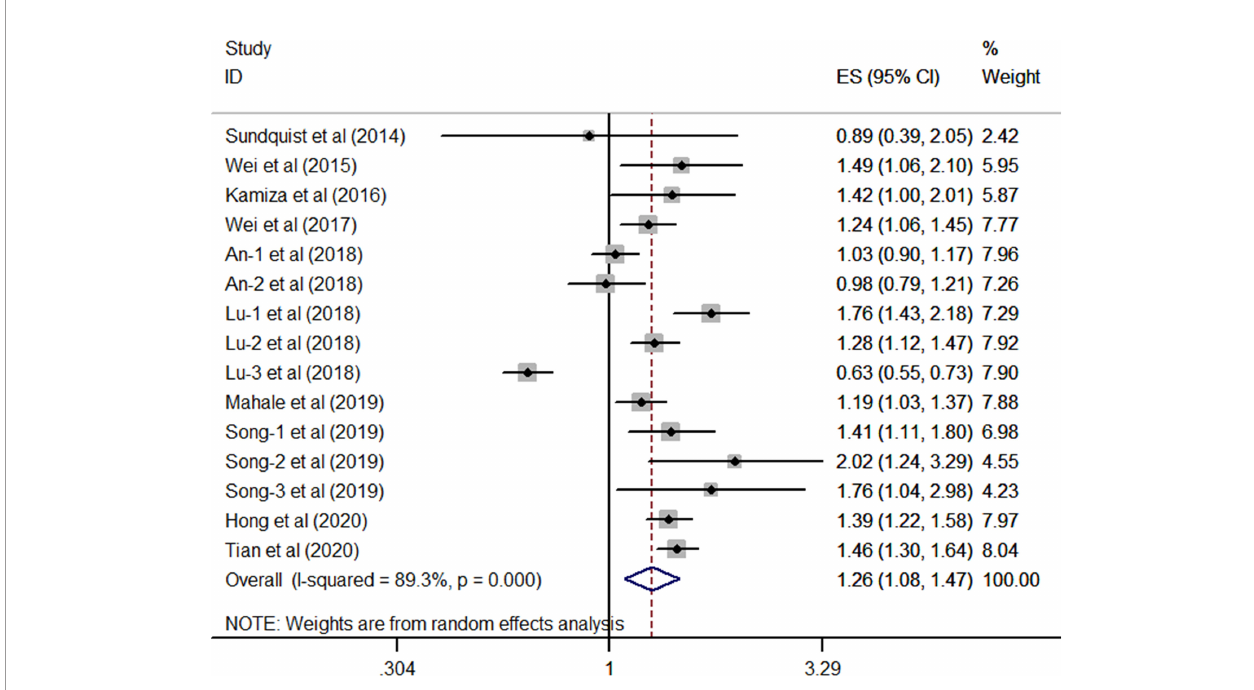
FIGURE 2 | Forest plots of the pooled analysis of the included studies on the association between HBV and risk of gastric cancer.